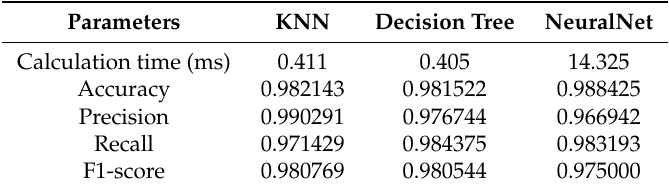
Table 7. Performance of different ML algorithms.